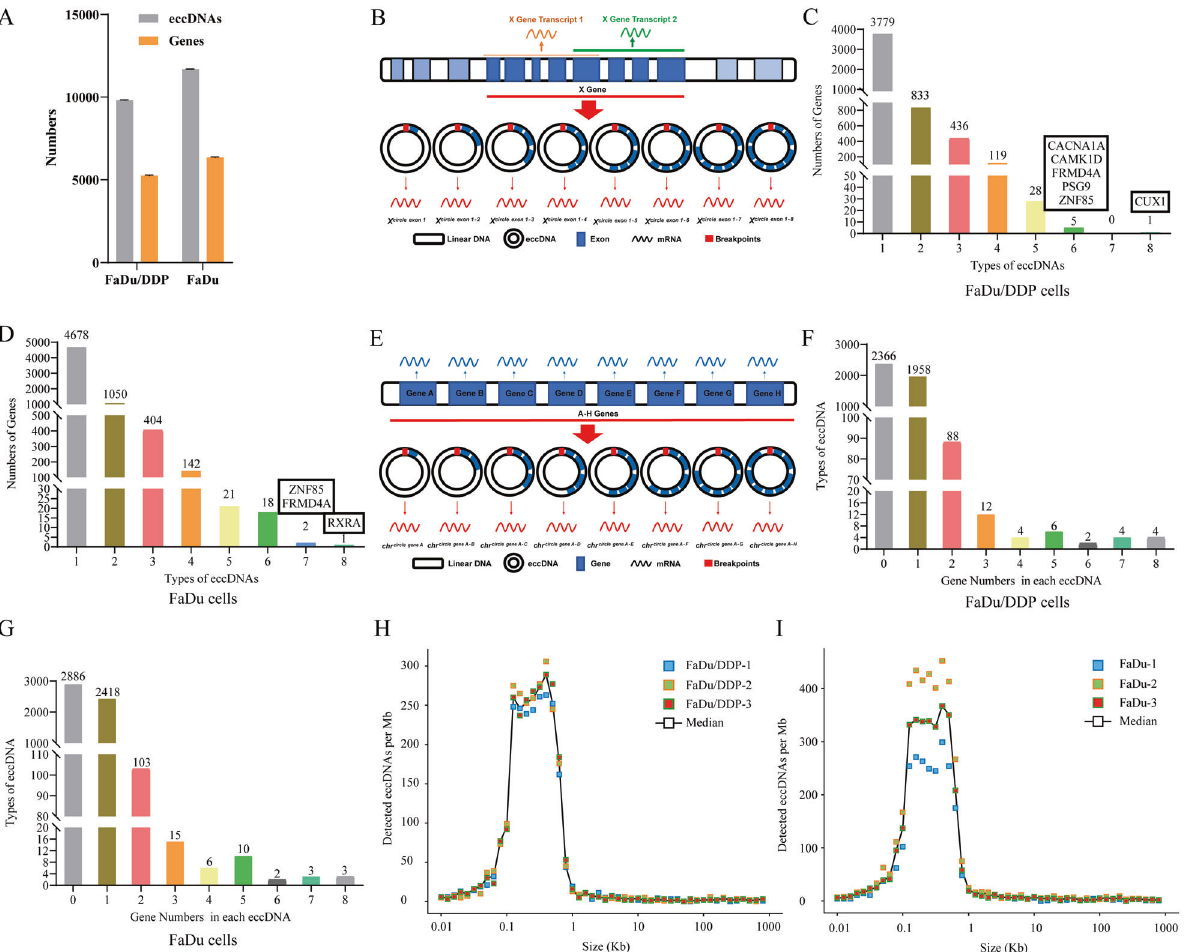
Fig. 1 Genome-wide detection of eccDNAs in FaDu/DDP and FaDu cells. A Number of eccDNA types and involved genes from FaDu/DDP and FaDu cells are depicted according to the cell lines. B Schematic representation of the mechanism of different types of eccDNA amplifying the same gene. C Number of genes derived from 1, 2, 3, 4, 5, 6, 7 or 8 different types of eccDNAs in FaDu/DDP cells. D Number of genes derived from 1, 2, 3, 4, 5, 6, 7 or 8 different types of eccDNAs in FaDu cells. E Schematic representation of the mechanism by which different types of eccDNAs amplify more than one gene. F Number of eccDNA types amplifying 1, 2, 3, 4, 5, 6, 7 or 8 different genes in FaDu/DDP cells. G Number of eccDNA types amplifying 1, 2, 3, 4, 5, 6, 7 or 8 different genes in FaDu cells. H Size of eccDNA ranged from 0.01 kb to 1000 kb in FaDu/DDP cells. I Size of eccDNA ranged from 0.01 kb to 1000 kb in FaDu